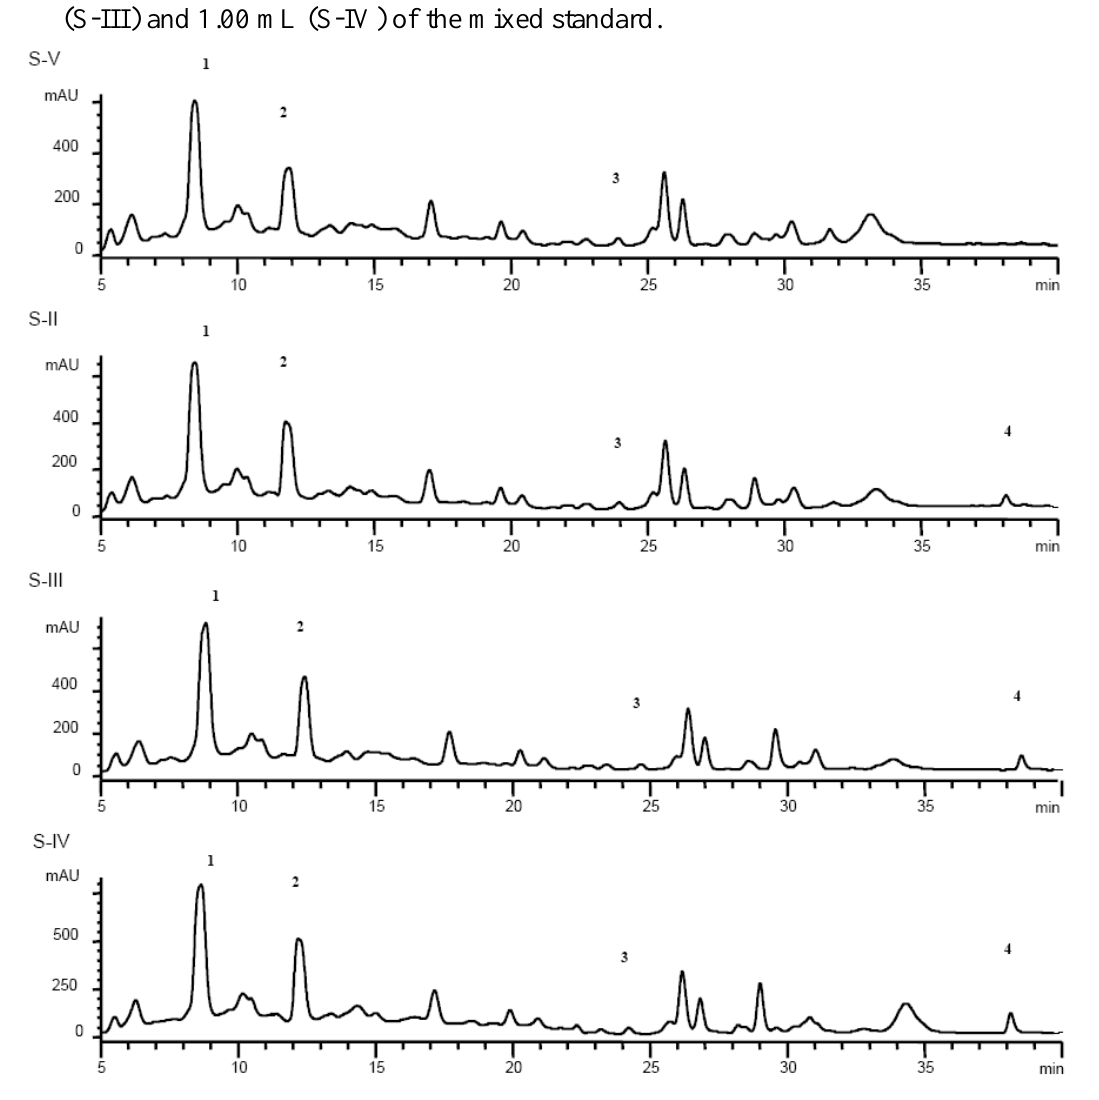
Figure 2. Chromatorgams acquired for the analysis of red grape berries of the Vertzami variety: 1. (+)-catechin, 2. (-)-epicatechin, 3. trans- resveratrol and 4. quercetin. Directly injected extract (S-V). Extracts injected after the addition of: 0.500 mL (S-II), 0.750 mL (S-III) and 1.00 mL (S-IV) of the mixed